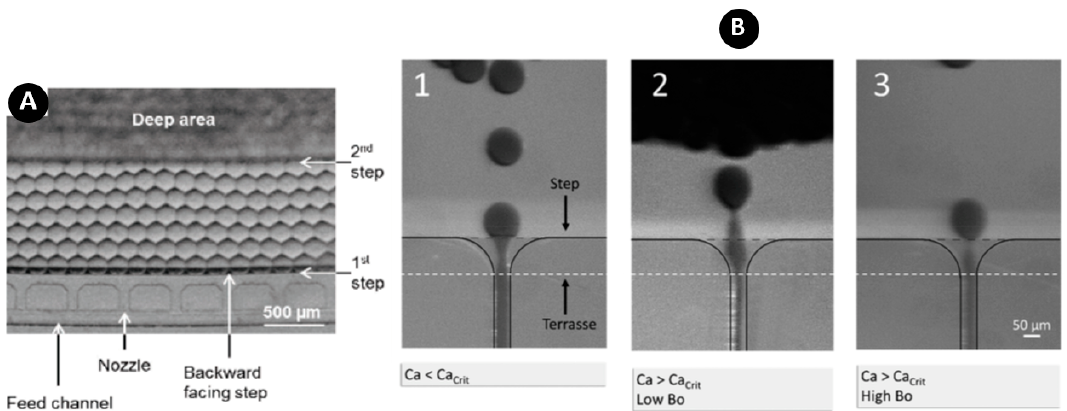
Figure 4. ( A ) Centrifugal force packs droplets together to form a hexagonal pattern by removing excess oil, and consequently, achieving high-volume fractions [109]; ( B ) Stroboscopic images of the detachment process at the nozzle for the dripping and jetting regimes in centrifugal step emulsification in which high buoyancy at high Bo numbers support rapid breakup process and monodisperse droplets.